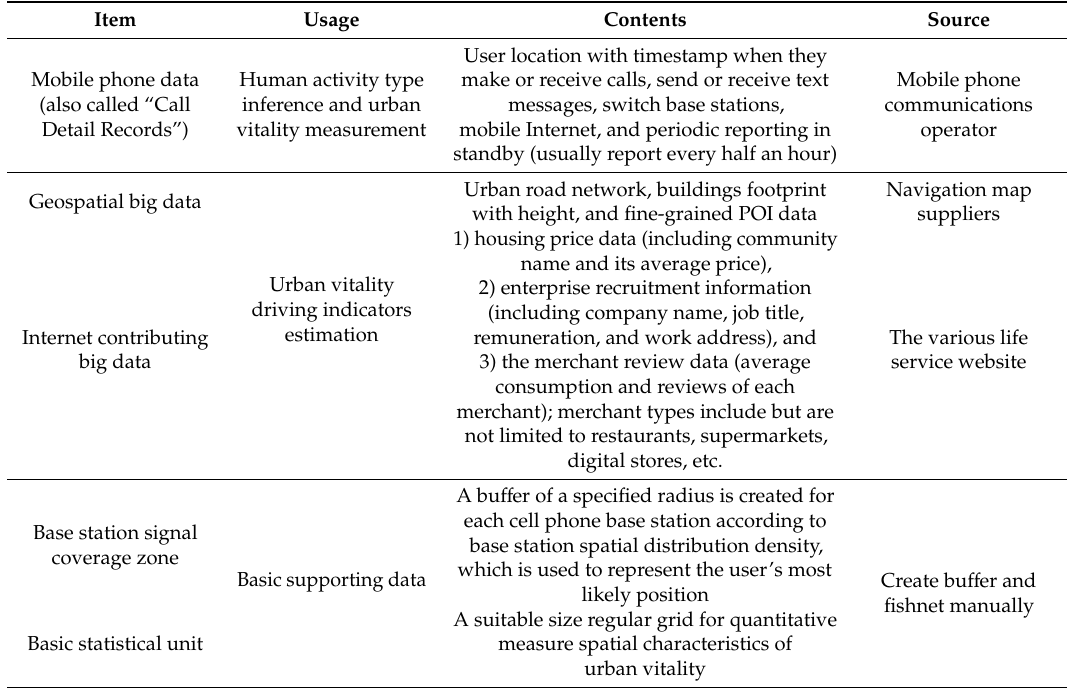
Table 1. The input datasets are used in this